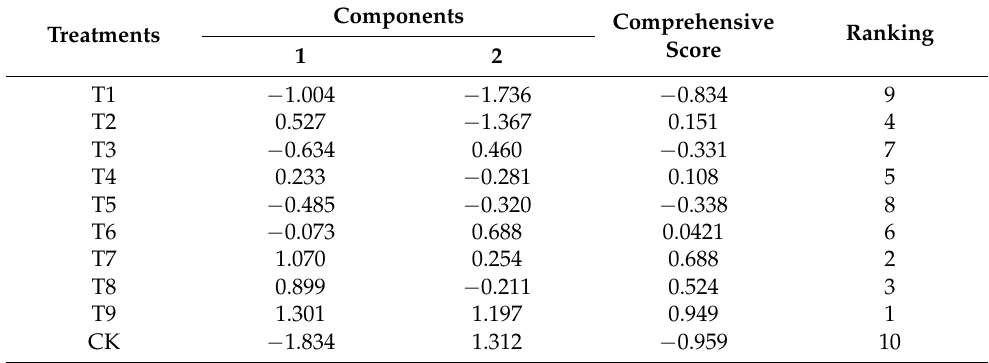
Table 3. Principal component scores, comprehensive scores, and rankings of different treatments. Treatments